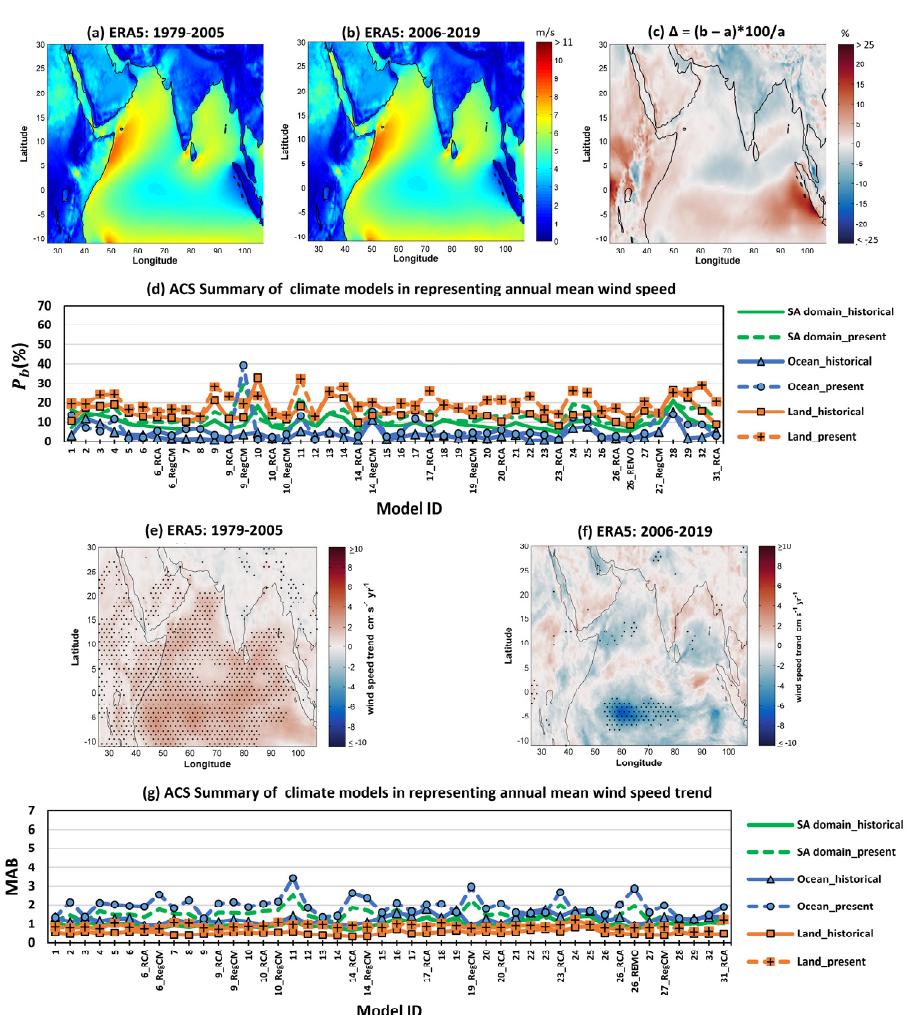
Figure 7. Annual mean wind speed (WS) spatial maps of ERA5 for the ( a ) historical (1979–2005) and ( b ) present time slice (2006–2019). ( c ) Percentage change of present mean WS relative to historical mean WS ( ∆ , %). ( d ) As in Figure 2, but this figure summarizes the climate model’s skill in simulating annual mean WS; percentage of statistically significant bias ( P b , %) on y-axis and Model ID on x-axis. ( e , f ) As in Figure 6, but for annual mean WS trend.